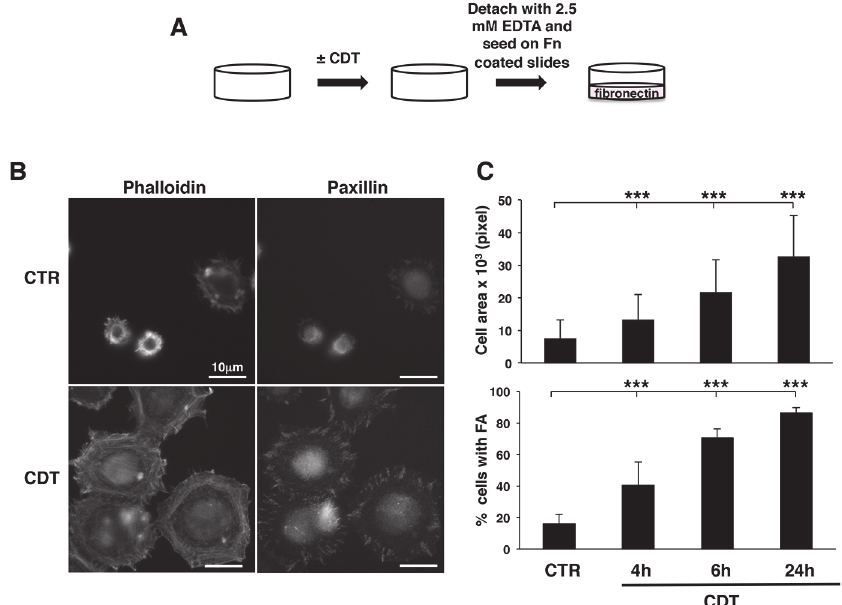
Fig 1. CDT intoxication promotes focal adhesions and cell spreading. A. Protocol for the adhesion/ spreading assay. HeLa cells were seeded and further left untreated or intoxicated with CDT (1 μ g/ml) for 4, 6 or 24h. At the indicated time points, cells were detached with 2.5 mM EDTA in PBS, and seeded on fibronectin (Fn)-coated glasses for 20 minutes, as described in Material and Methods, prior fixation and immunofluorescence analysis. B. Representative micrographs of HeLa cells untreated (CTR) or intoxicated for 24h (CDT) after 20 minutes adhesion on fibronectin-coated glasses. The actin cytoskeleton was visualized by phalloidin staining (left panel) and the focal adhesion complexes were visualized using an anti- paxillin antibody (right panel). C. Quantification of cell spreading and formation of focal adhesion complexes of HeLa cells left untreated (CTR) or intoxicated (CDT) for the indicated period of times. The upper panel shows the area of 400 randomly selected adherent cells, measured using the ImageJ software. The lower panel shows the percentage of cells carrying more than 5 focal adhesion complexes/cell, identified by paxillin staining. The data are presented as the mean ± SEM of three independent experiments. Statistical analysis was performed using the Student t-test. *** p value <